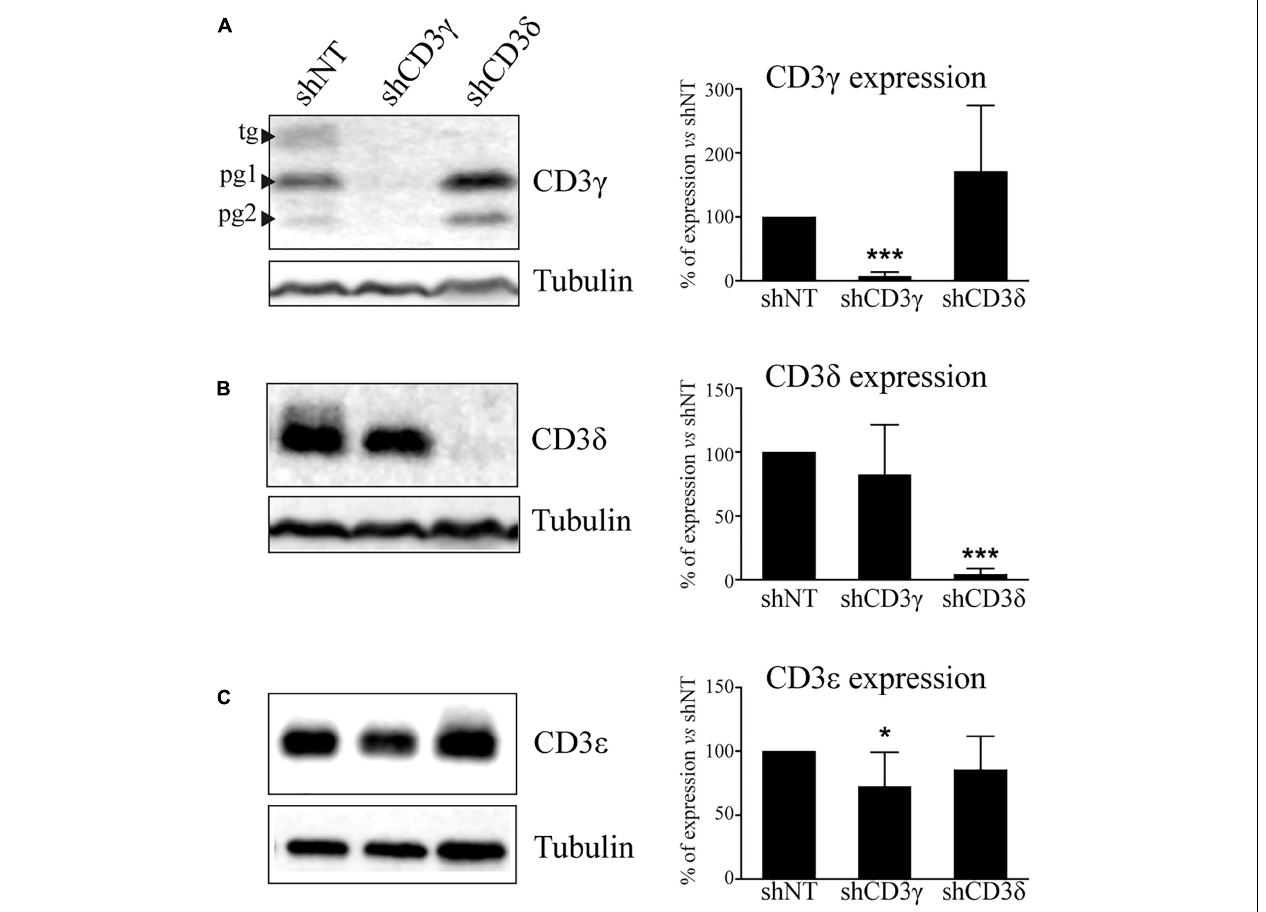
FIGURE 2 | CD3 protein expression in CD3G or CD3D KD T-cell lines. Jurkat E6-1 cells were transfected with shCD3 γ , shCD3 δ , and shNT. Cells were lysed in NP-40 buffer after several days in culture with puromycin and 40 µ g of total protein was loaded. Membranes were incubated with antibodies against tubulin (Sigma) and (A) CD3 γ (Abcam), (B) CD3 δ (Santa Cruz Biotechnology), or (C) CD3 ε (Abcam). Band analysis and numbers as in Figure 1 . Left: a representative experiment. Right: quantification of at least 10 different experiments; data are mean values + SD. Tg, totally glycosylated; pg, partially glycosylated. Note: all glycosylated forms of CD3 γ were quantified